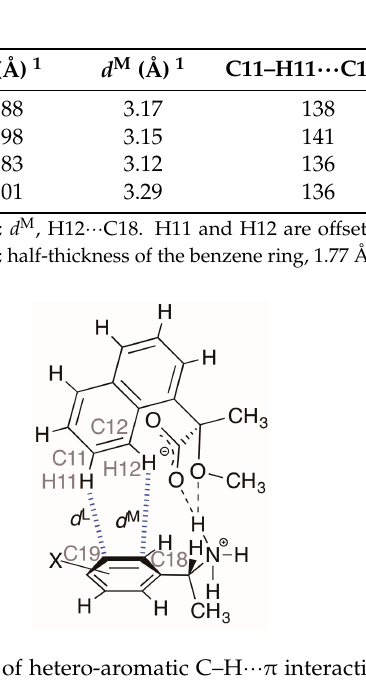
Figure 7. Geometrical parameters of hetero-aromatic C–H ∙∙∙π interactions in the close ion-pairs of salts 6 – 9 .